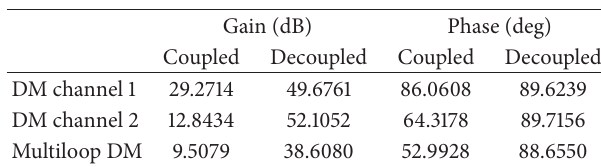
Table 4: Disk margins of the system with 2-way